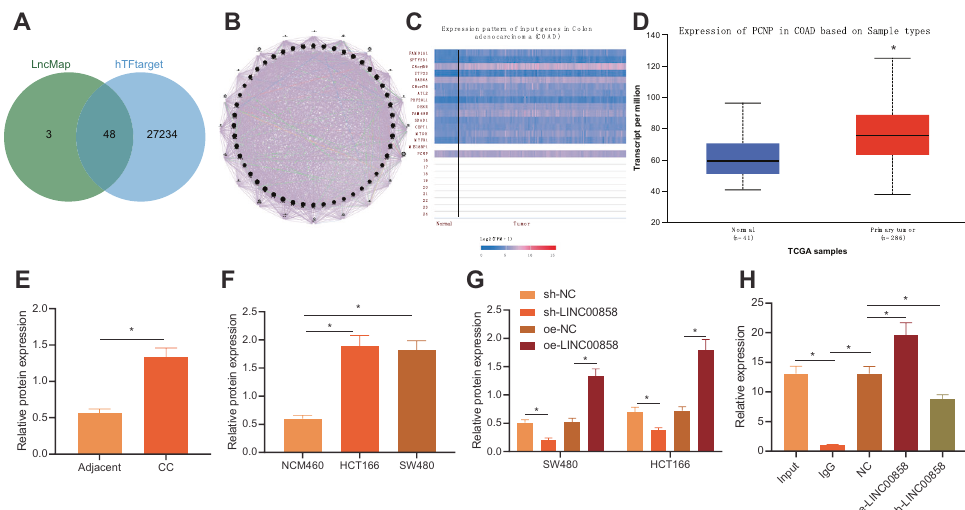
Fig. 3 LINC00858 promotes PCNP transcription by recruiting RAD21. A Venn diagram of the intersection of RAD21 downstream target genes obtained from LncMAP and HTF target websites. B Coexpression network diagram of genes constructed using GeneMANIA. C Expression heat map of 16 candidate genes in TCGA-included colon cancer constructed using UALCAN. D The expression of PCNP in colon cancer samples determined using UALCAN. * p < 0.05, vs. normal samples. E The protein expression of PCNP in colon cancer tissues and normal adjacent tissues of patients with colon cancer ( n = 50) detected by Western blot assay. * p < 0.05, vs . normal adjacent tissues. F The protein expression of PCNP in human normal colon cell line (NCM460) and colon cancer cell lines (SW480 and HCT166) detected by Western blot assay. G The protein expression of PCNP in SW480 and HCT166 cells from each group detected by Western blot assay. H ChIP assay to detect the binding between RAD21 and PCNP promoter and determination of the effect of LINC00858 on their binding. * p < 0.05. Data from multiple groups were compared using one-way ANOVA with Tukey ’ s post hoc tests. All cell experiments were repeated three (Fig. 5C – F). Western blot assay results indicated that the